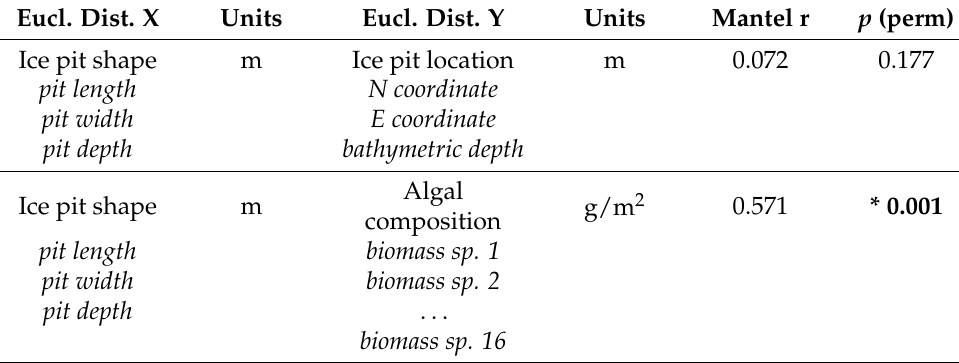
Table 2. Two Mantel tests using Euclidean distance matrices that test for correlations between pairwise similarity among ice pit shapes and their physical proximities (i.e., spatial autocorrelation) and between pairwise similarity among ice pit shapes and the species composition of sixteen algal species. Significance values are based on 999 permutations.